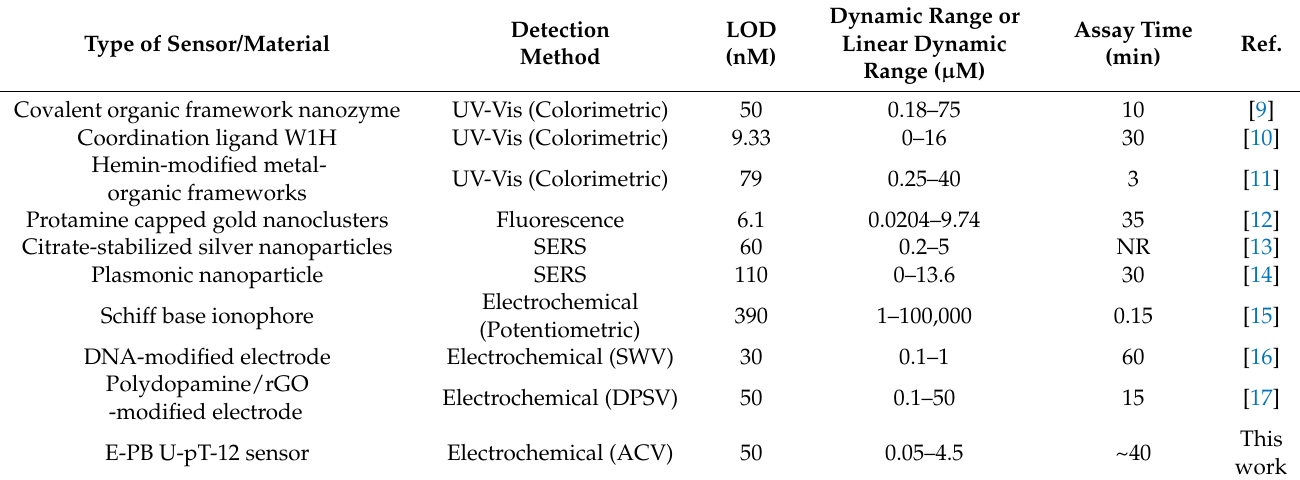
Table 1. A comparison of the key analytical properties of the U-pT-12 sensor and other U(VI) sensors and detection